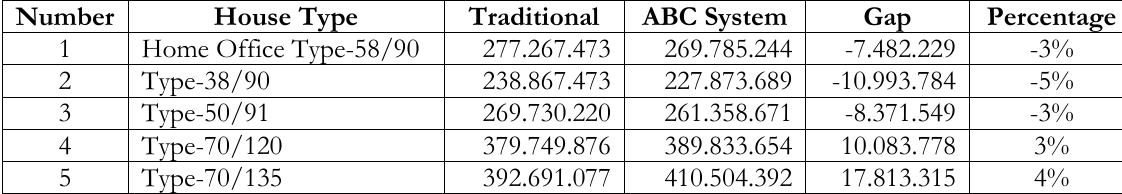
Table 10. Comparison of Company Calculations with ABC